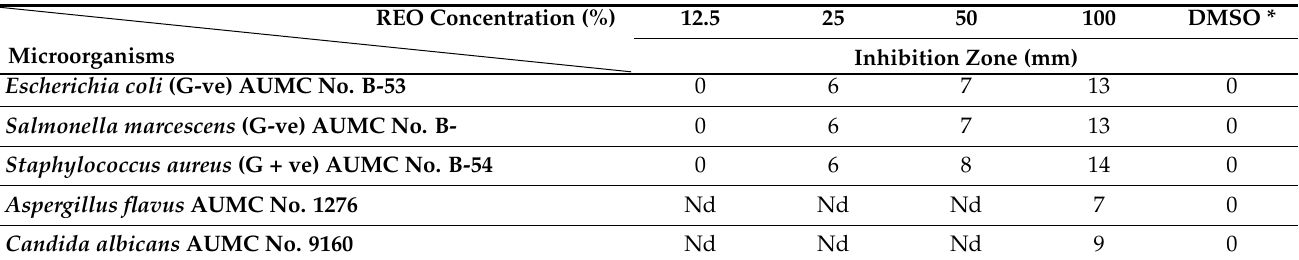
Table 2. Minimum inhibitory concentration (MICs) of REO with some species of